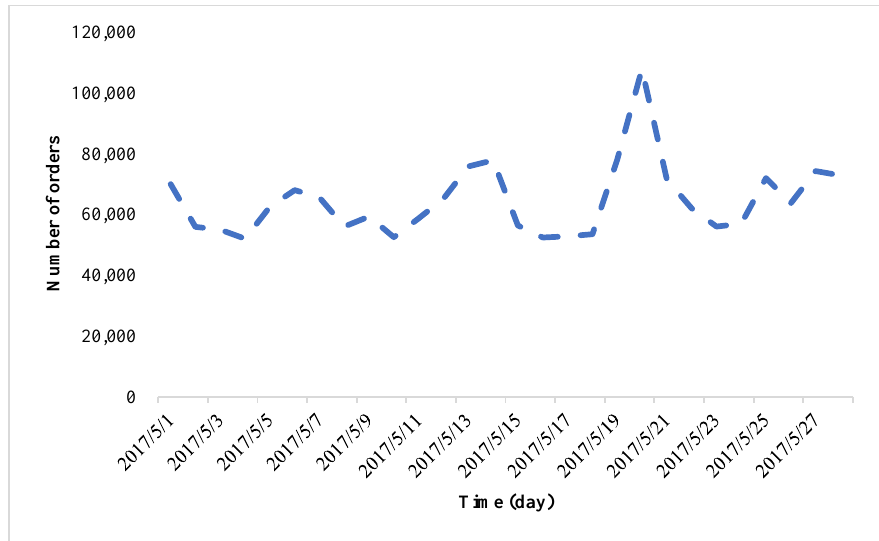
Figure 5. Relationships between demand and date of online car-hailing.